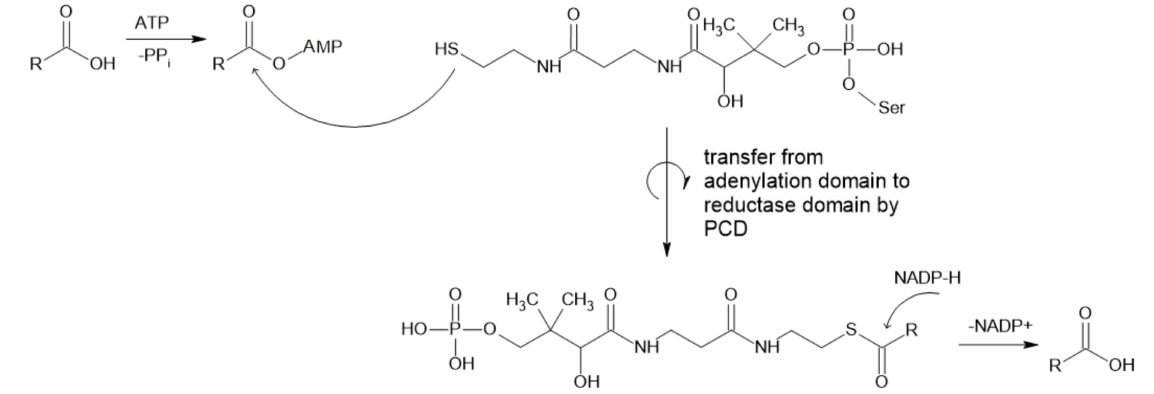
Figure 1. Mechanism of reaction catalyzed by CAR (PCD—peptidyl carrier domain).